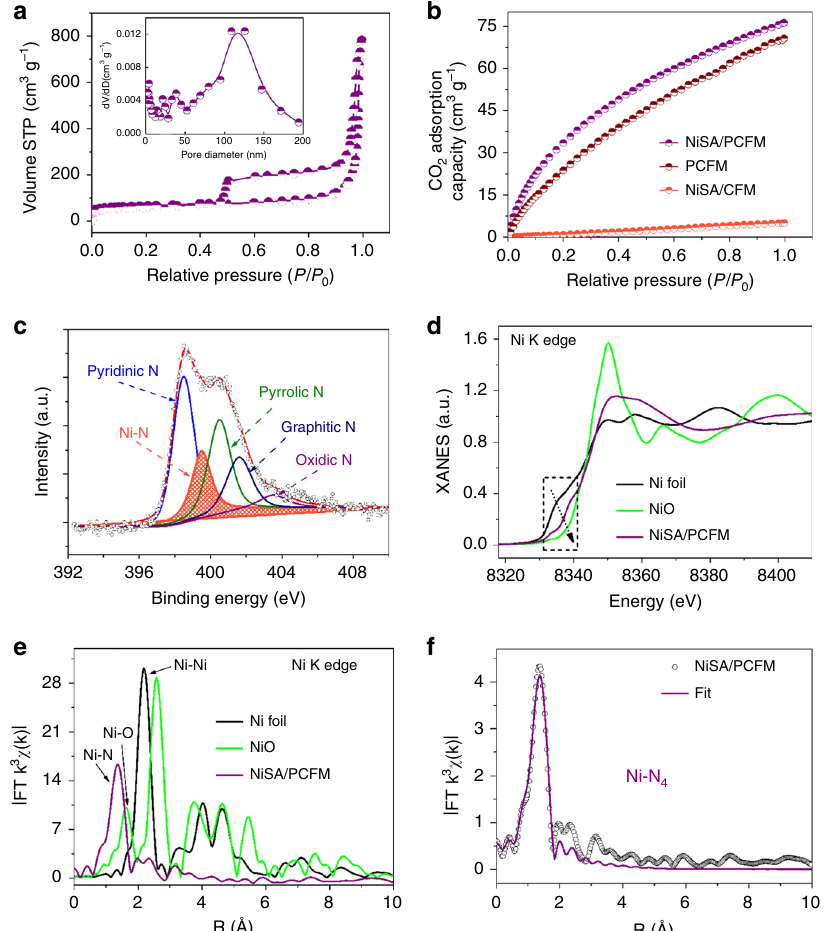
Fig. 3 Chemical analysis of NiSA/PCFM. a N 2 sorption isotherms of NiSA/PCFM, inset shows the pore size distribution. b CO 2 adsorption amount of various catalysts. c N 1s XPS spectra of NiSA/PCFM. d XANES spectra at the Ni K-edge of Ni foil, NiO and NiSA/PCFM; e The Fourier transform of EXAFS data for three samples; f Fitting for the EXAFS data of NiSA/PCFM, inset is the Ni-N 4 -C structure, Ni (green sphere), N (blue sphere), and C (gray